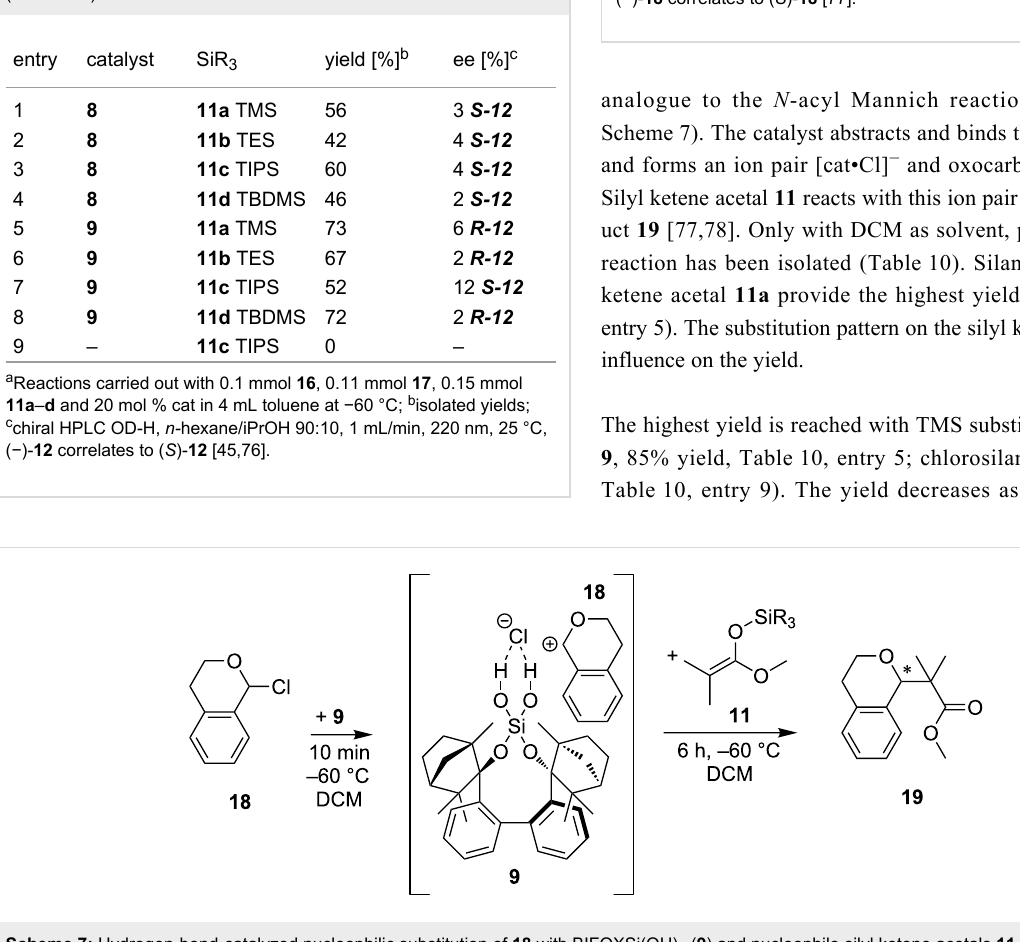
Table 9: Performance of catalyst 8 and 9 in the N -acyl Mannich reac- tion with 10 and different silyl ketene acetals 11a – d and yielding in 12 (Scheme 6) a .